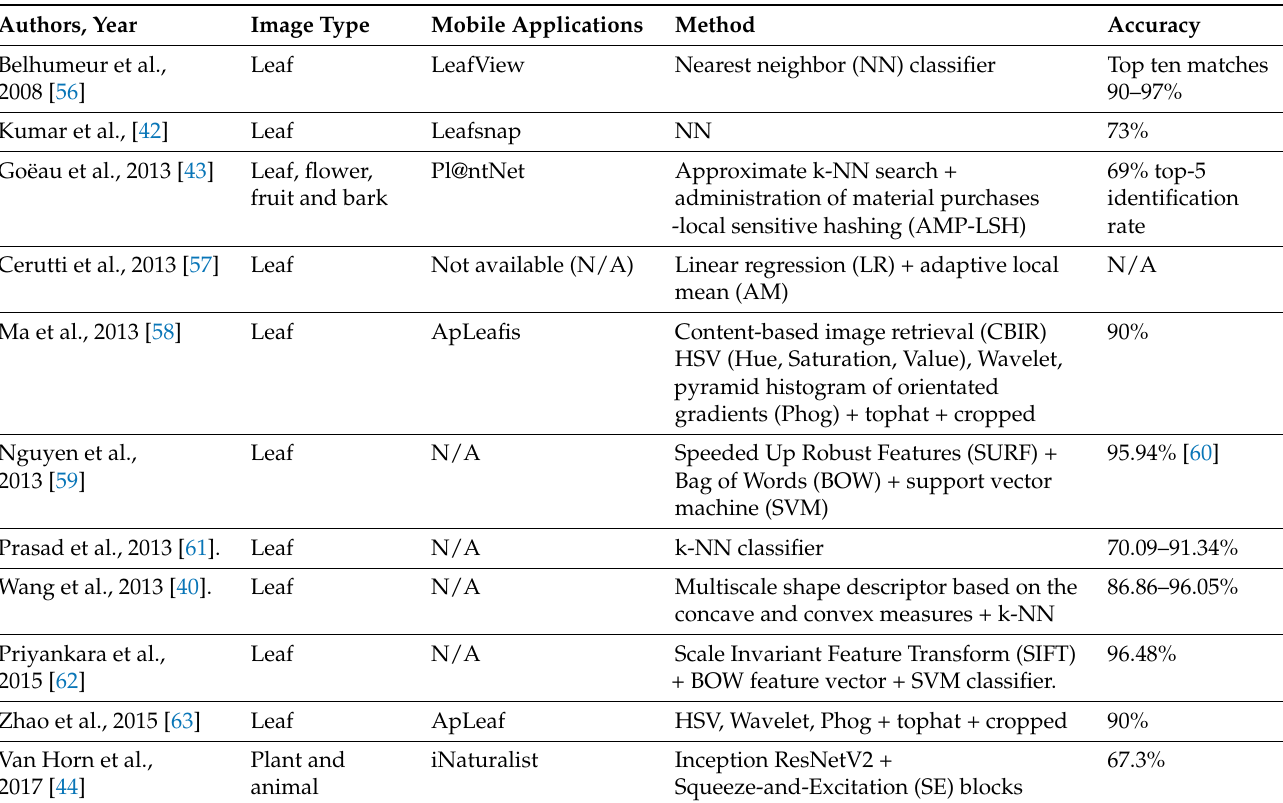
Table 2. Summary of related works in mobile